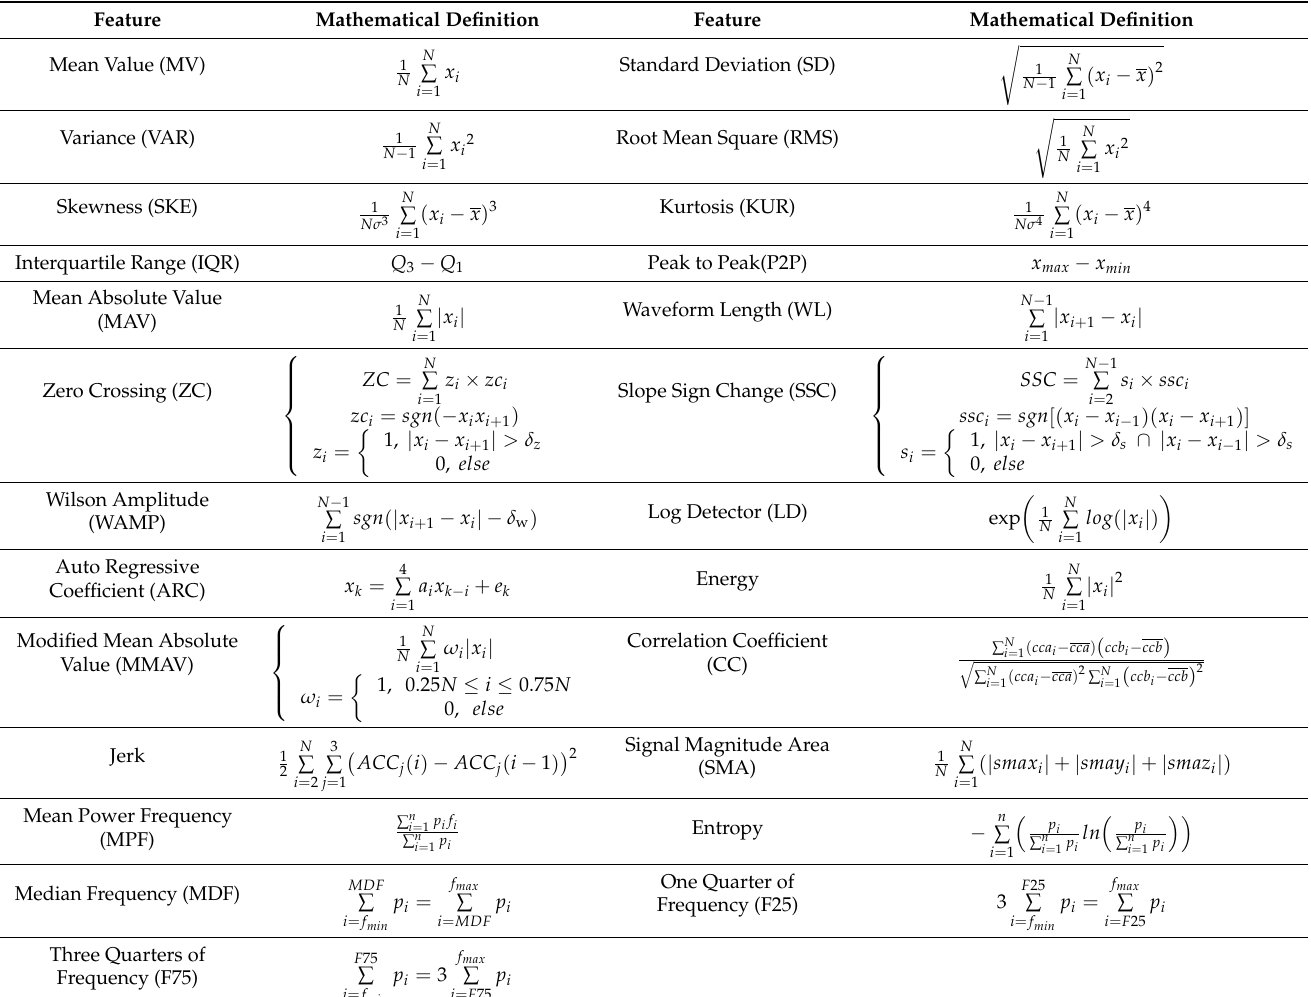
Table 1. Mathematical definitions of features.